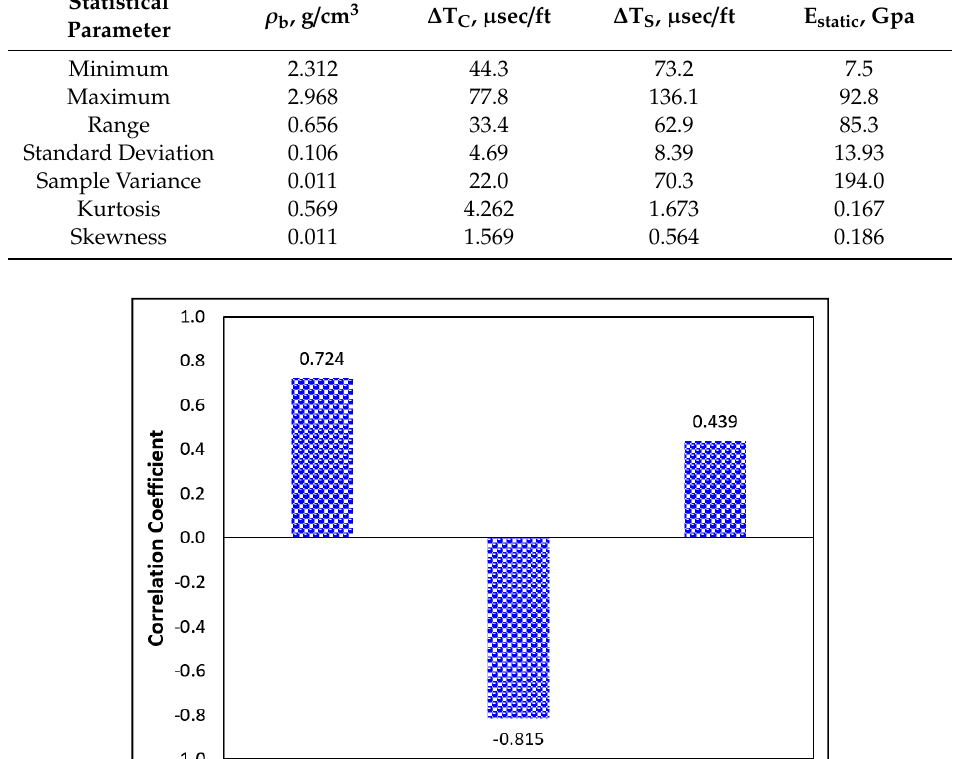
Table 2. Combination of the design